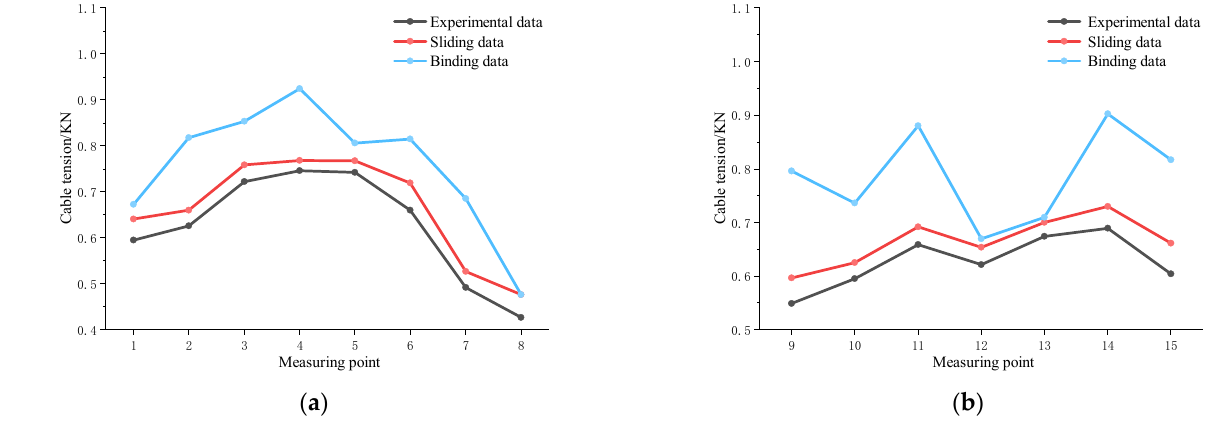
Figure 26. Cable tension comparison curve. ( a ) Comparison curve of long cable data; ( b ) Comparison curve of short cable data. Table 2. Comparison of cable end axial tension.